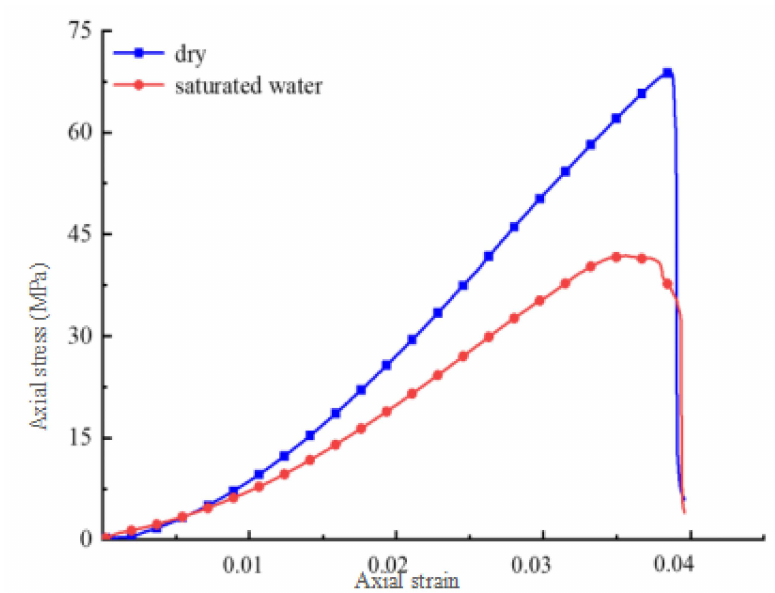
Figure 5. Stress-strain curves of dry and saturated